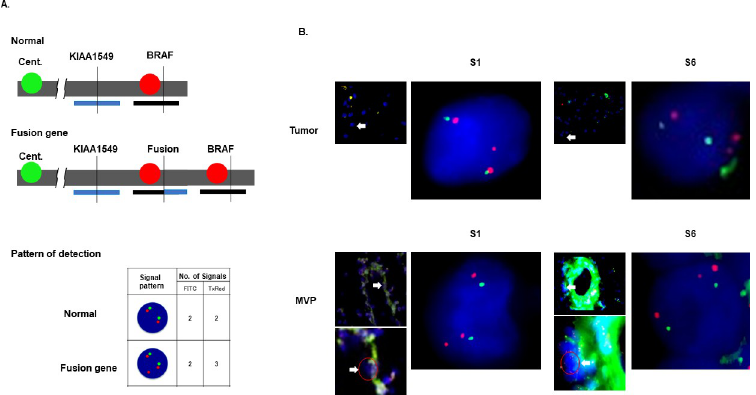
Fig 5. FISH analysis for the detection of the KIAA-BRAF fusion gene. (A) FISH probes at the duplication site of the BRAF gene (7q34) are labeled with Texas red. The centromere of chromosome 7q (7q11.21) is labeled with fluorescein isothiocyanate (FITC, green). Due to tandem duplication at 7q34 leading to the expression of the KIAA-BRAF fusion gene, cells with the fusion gene demonstrated gain of a red signal (total: three signals) in comparison with the green signal (two signals). (B) In both S1 and S6, tumor cells and cellular components of MVP were positive for the KIAA-BRAF fusion gene.